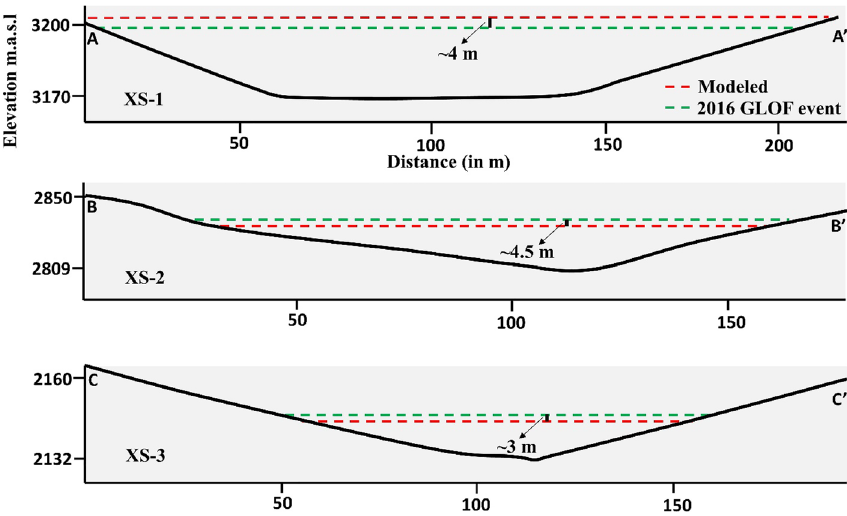
Figure 6. Comparison of the modeled flow inundation and the 2016 Gongbatongsha debris flow along three cross-sections of the flow path; the locations of the cross-sections are marked in Fig.